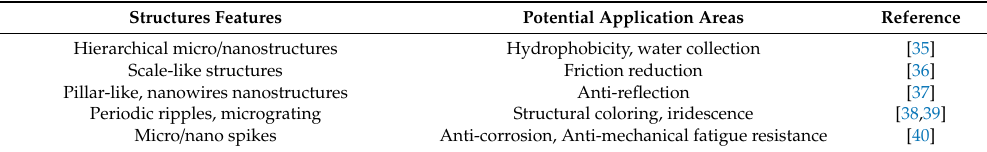
Table 1. Laser induced structures and potential areas of